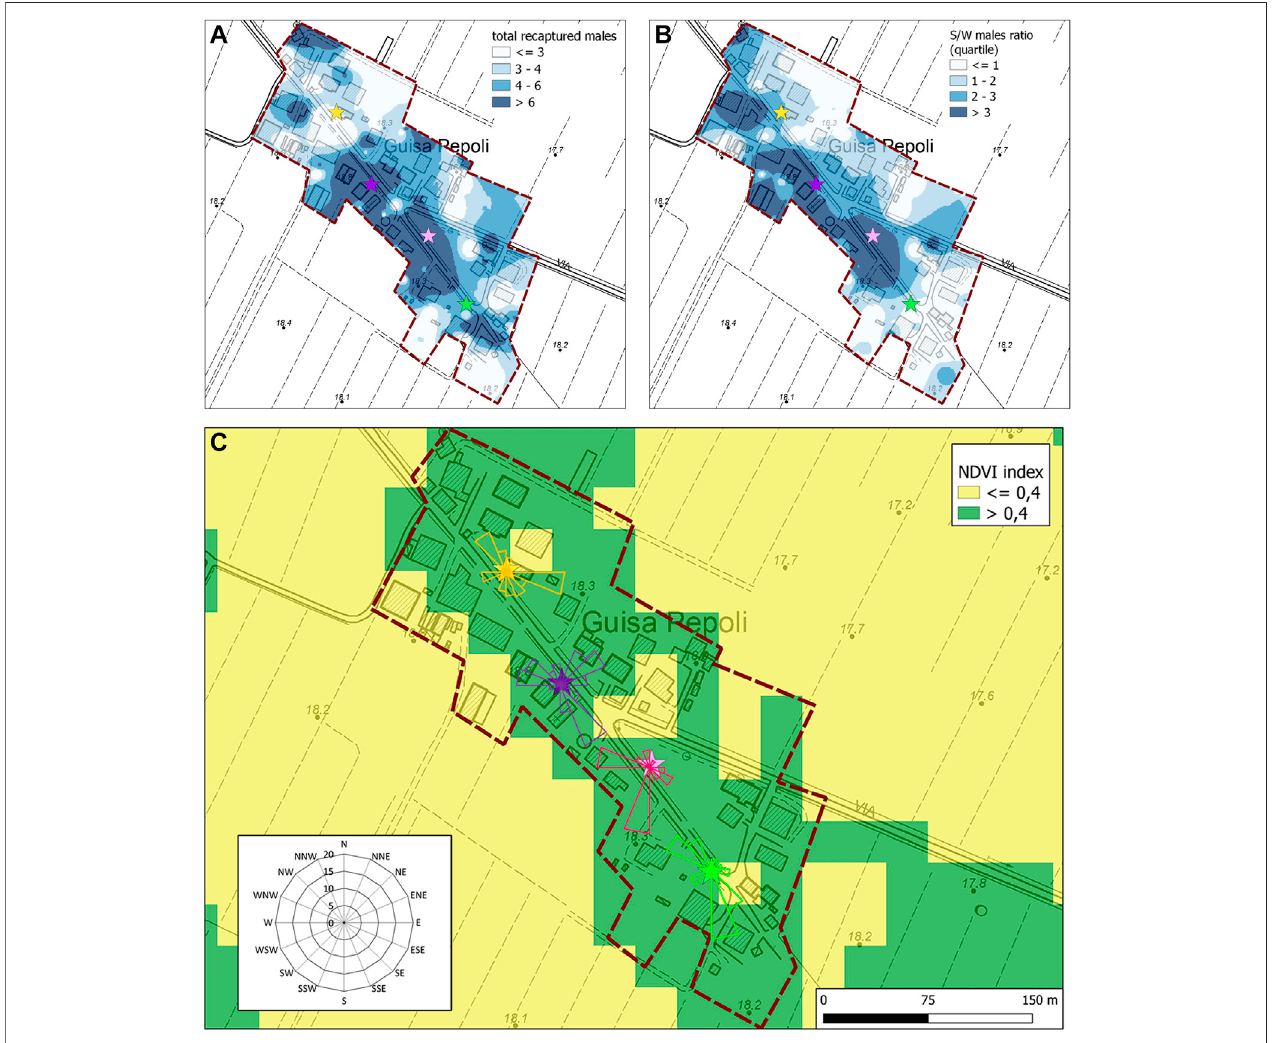
FIGURE4| Summarymapof (A) thetotalrecapturedmalesand (B) S/Wratiooftherecapturedmales(IDWinterpolationrasters)inGuisaPepoliduringthesecond MRR trial. Colored stars represent the release points. (C) Normalized difference vegetation index (NDVI) map and direction dispersion of sterile males in Guisa Pepoli in the second MRR trial. The direction and the dimension of the bands in the rose diagram show the direction and intensity of the sterile male ’ s distribution.